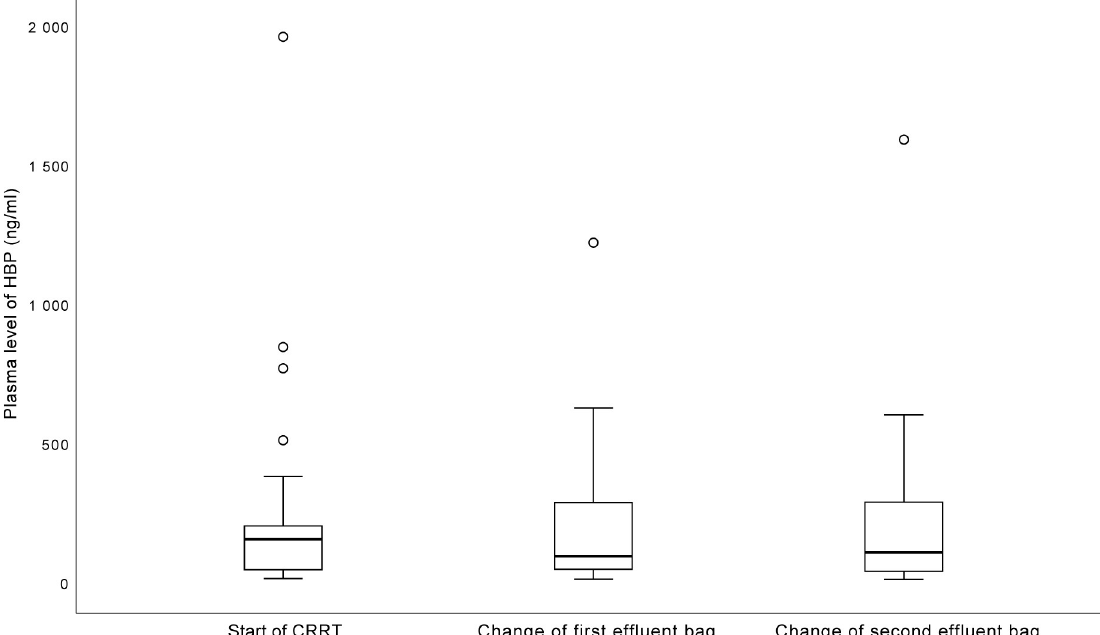
Fig 2. Plasma levels of heparin binding protein (HBP) after the start of CRRT. Boxes indicate the second to third quartile with the median. Brackets indicate min-max values. Circles indicate outliers. There was no significant difference between first and last registration (p = 0.14).